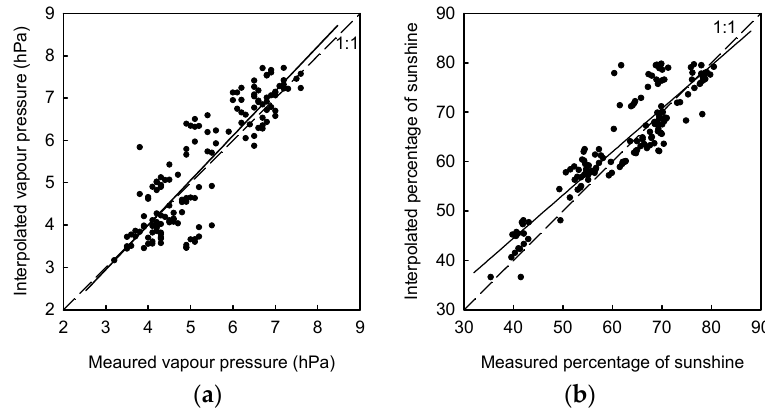
Figure 6. Validation of the ANUSPLIN method in interpolating ( a ) water vapor pressure and ( b ) sunshine percentage over the Tibetan Plateau and its surrounding regions.